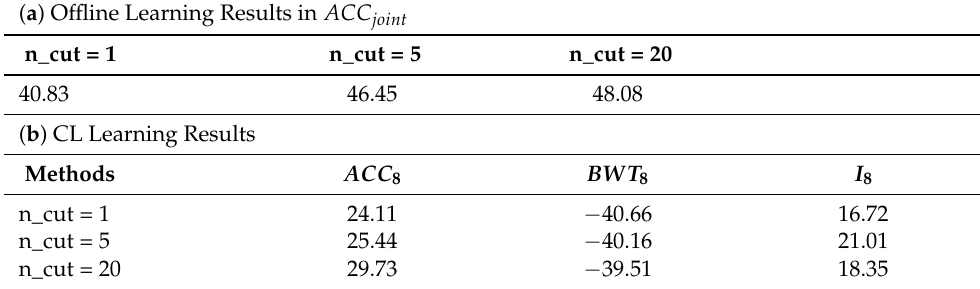
Table 1. Experiment results from offline and continual learning using DAS-Spectrogram dataset on different augmentation